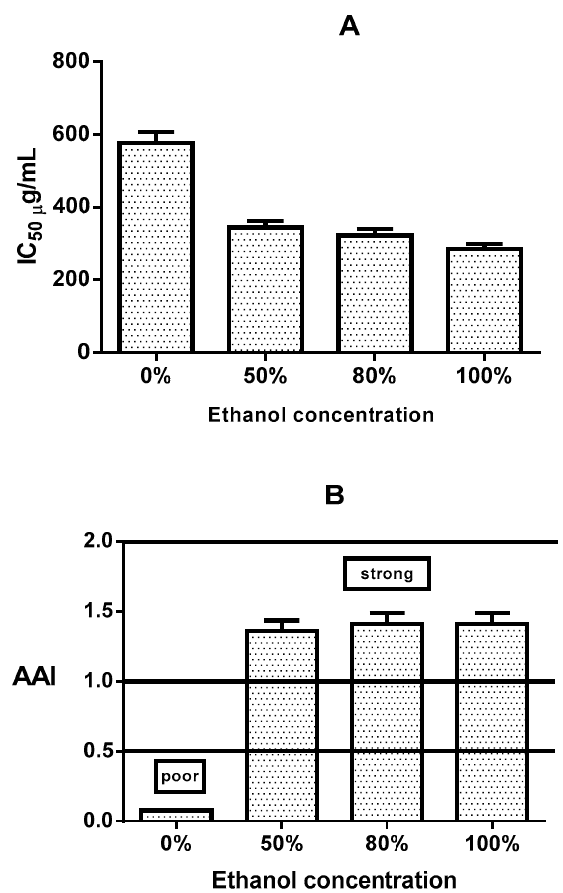
Figure 5. IC 50 values and antioxidant activity index (AAI). Individual samples of B . x buttiana extract ethanol 0%, 50%, 80%, and 100% were investigated to evaluate the IC 50 ( A ) and antioxidant activity index ( B ) as described in Materials and Methods. Each bar corresponds to the results (mean ± standard deviation (SD)) from three different preparations.